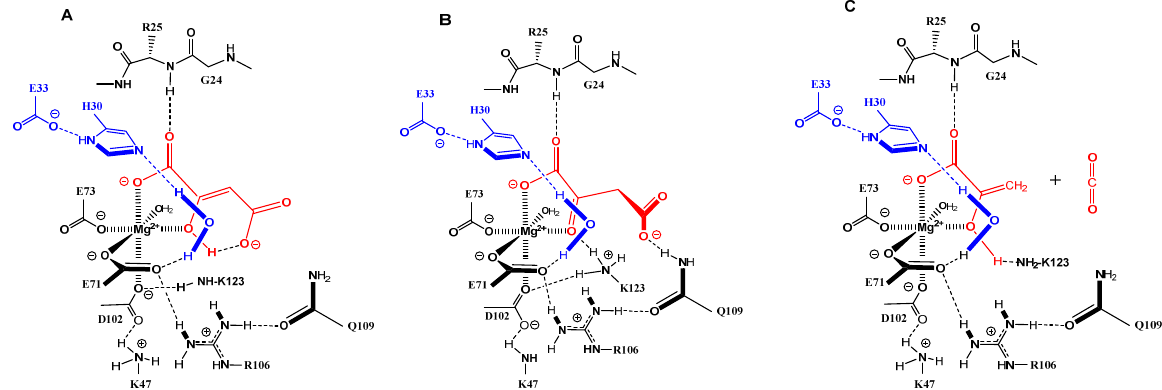
Figure 2. Mg-bound enol form of OAA (red, ( A )); Q109 promoted the conformational control of ketonized OAA (red, ( B )); quench of the primary enolate of pyruvate by K123 to pyruvate–enol and CO 2 release (red, ( C )); blue: catalytic dyad E33-H30 and captured water molecule; dotted black lines: hydrogen bonding; filled bonds are in front and point towards the viewer).